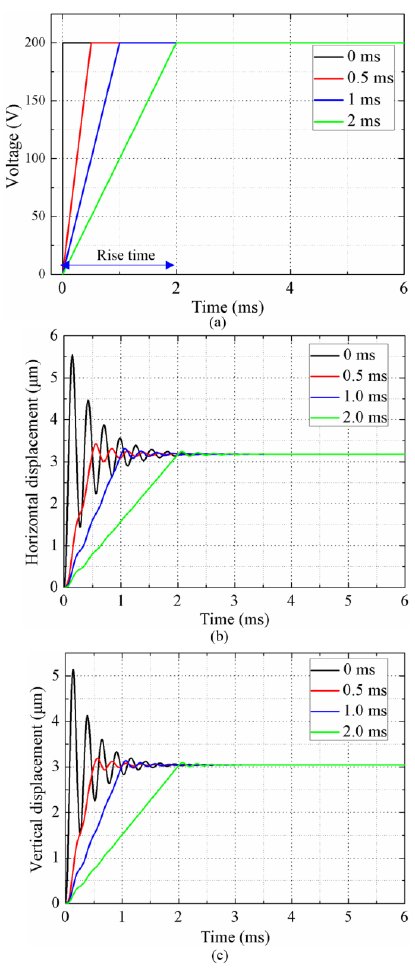
Figure 5. The transient response of the driving foot under step signals with different rise time. ( a ) Driving signals. ( b ) The displacement in horizontal direction. ( c ) The displacement in vertical direction.